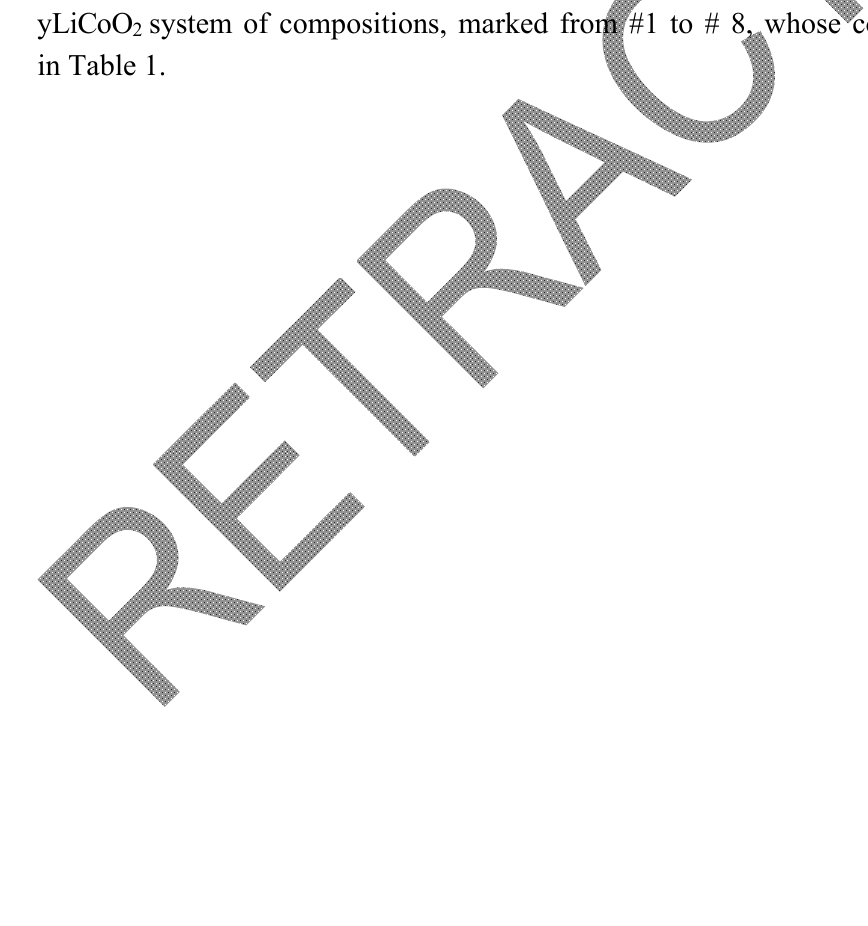
Co O • xLi MnO 0.8 0.2 2 2 3